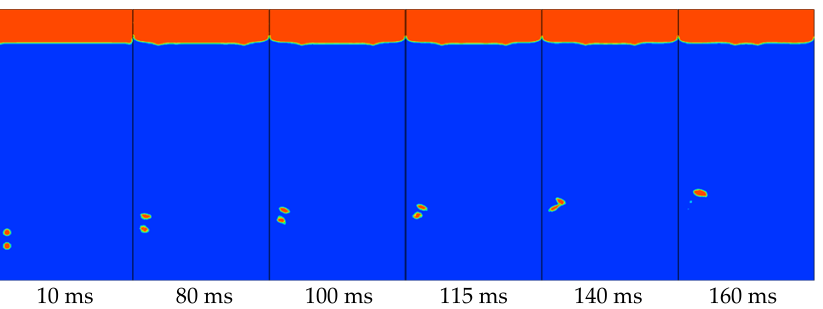
Figure 11. The shape change diagram of the rising double bubbles vertically arranged near the wall. Error! Reference source not found. is the flow field diagram of the bubble at different moments. At 80 ms, the bubble moves away from the wall due to the influence of the wall at this time. At 110 ms, the bubble forms a wake vortex due to the deflection, and the right wake vortex of the head bubble has an impact on the tail bubble, causing the bubble to